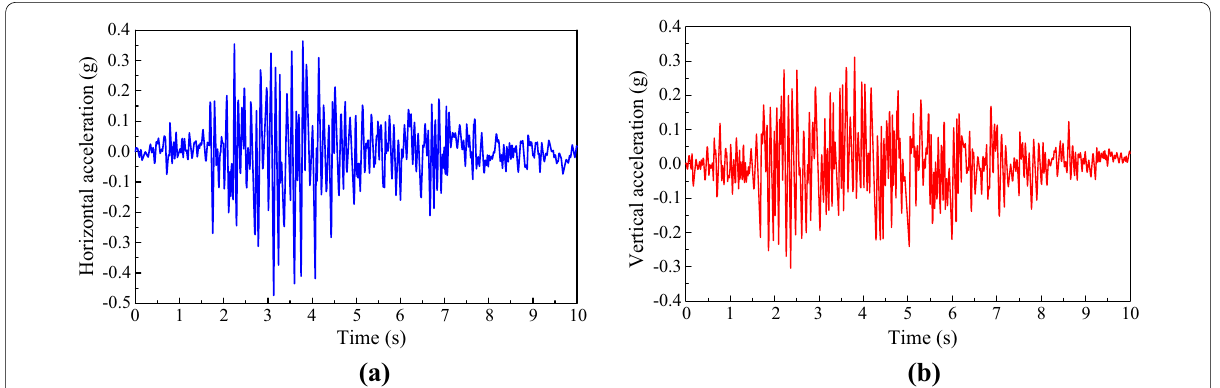
Fig. 24 Measured time history curves of seismic wave acceleration in 1967 (National Research Council, 1990): a horizontal acceleration and b vertical acceleration